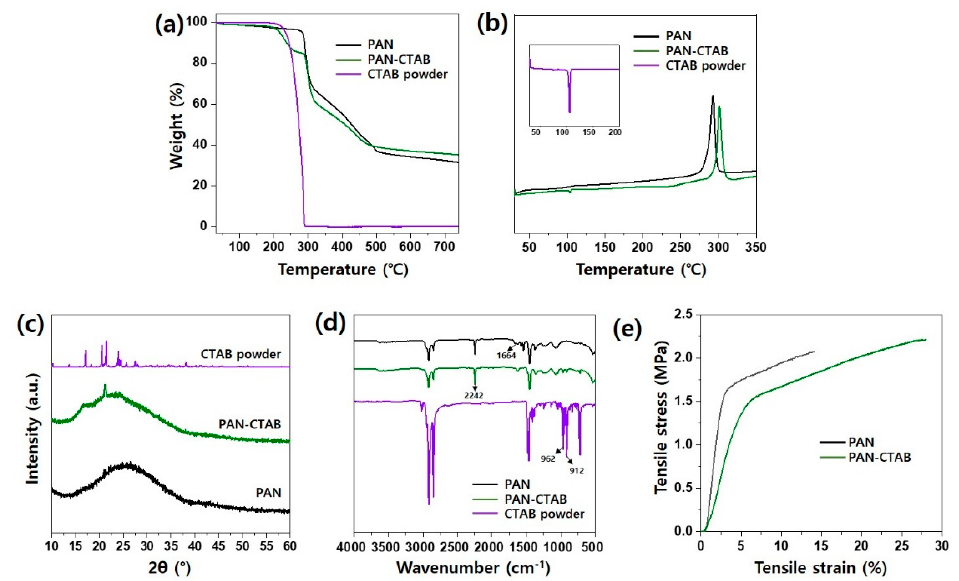
Figure 3. Characterizations of PAN nanofiber web, PAN–CTAB nanofiber/nanonet web, and CTAB powder. ( a ) Thermogravimetric analysis (TGA), ( b ) differential scanning calorimetry (DSC), ( c ) X-ray diffraction (XRD) patterns, and ( d ) Fourier transform infrared (FT-IR) spectra results of the three groups, respectively. ( e ) S–S curves of the PAN nanofiber and PAN–CTAB nanofiber/nanonet